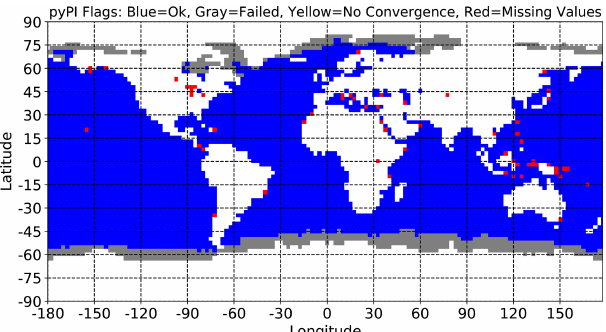
Figure 2. pyPI status flags from September 2004 potential intensity calculations when miss_handle = 1. Blue grid cells indicate the PI algorithm converged, gray grid cells indicate the PI algorithm failed to pass a check, yellow grid cells indicate the PI algorithm did not converge, and red grid cells indicate the PI algorithm failed due to missing profile